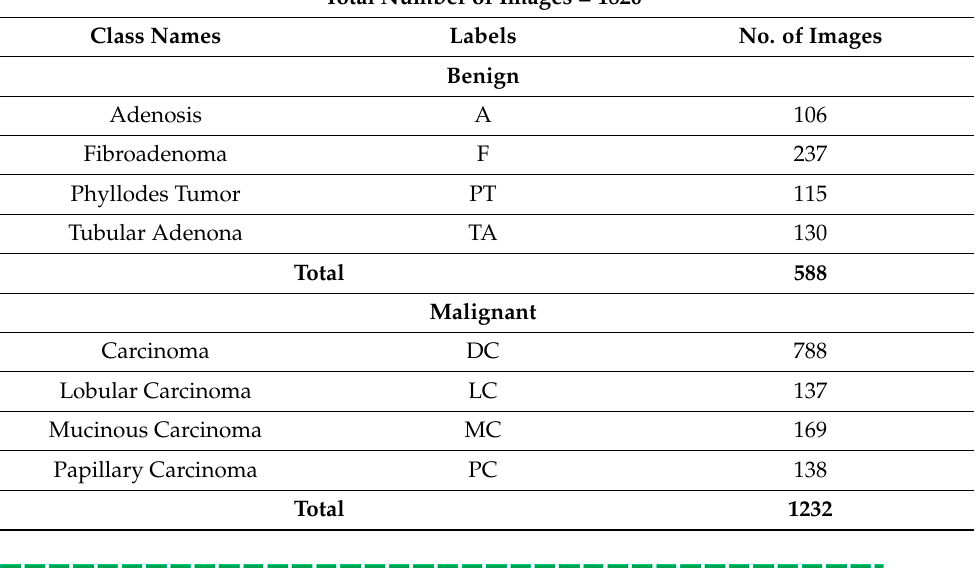
Table 1. Dataset details.